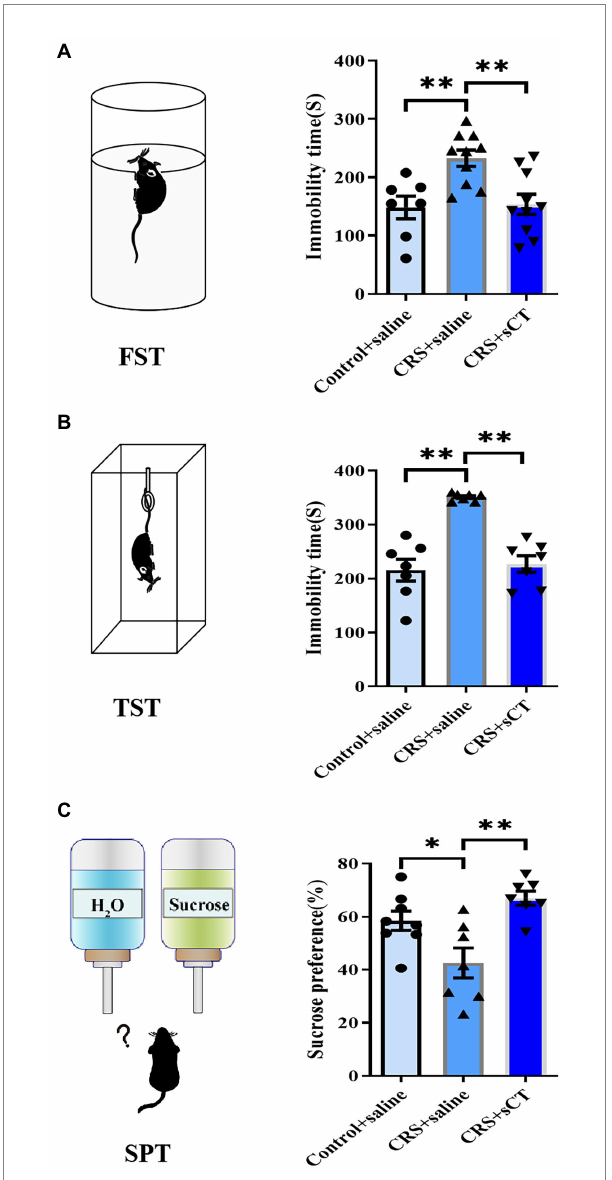
FIGURE 2 Chronic sCT treatment had an antidepressant effect in CRS-treated mice. (A) In FST, the immobility time of CRS-treated mice was increased and was decreased after sCT treatment (Control + saline: n = 7; Depression + saline: n = 10; Depression + sCT: n = 10). (B) In TST, the immobility time of CRS-treated mice was also significantly increased and was decreased after sCT treatment (Control + saline: n = 7; Depression + saline: n = 7; Depression + sCT: n = 7). (C) In SPT, the sucrose preference of CRS-treated mice was decreased significantly and was increased after sCT treatment (Control + saline: n = 8; Depression + saline: n = 7; Depression + sCT: n = 7). The data were analyzed by one-way ANOVA with Tukey’s multiple comparison tests. * p < 0.05, ** p <